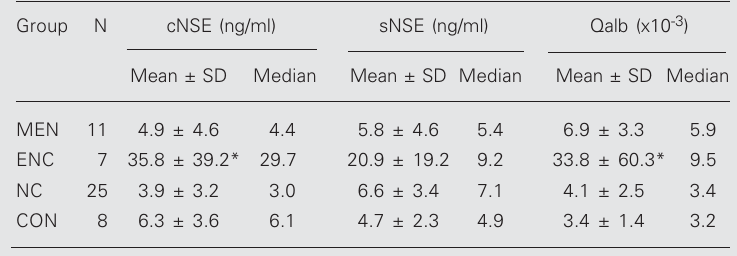
Table 1. Distribution of neuron-specific enolase (NSE) levels and albumin quotient among the groups studied. Group